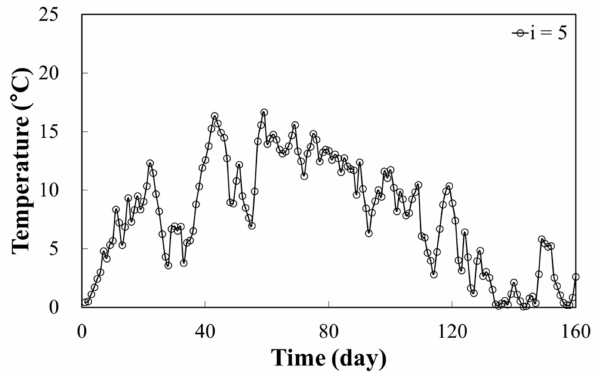
Figure 10. Daily average soil temperature at the uppermost depth in the site